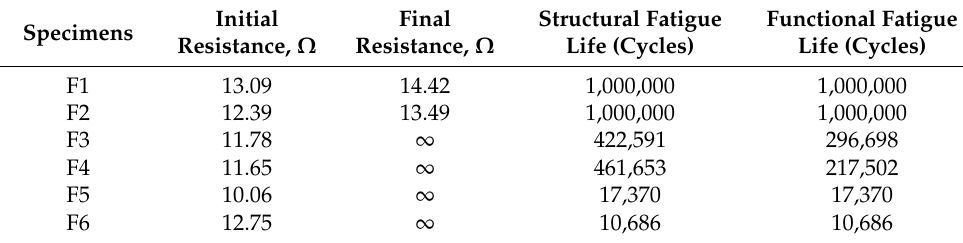
Table 3. Results of mechanical cycling test.